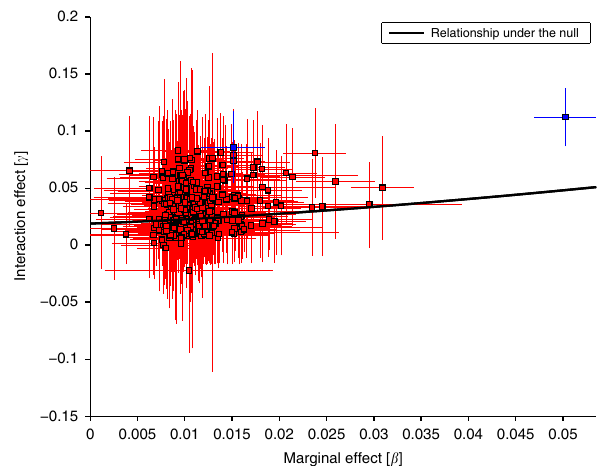
Fig. 6 Interaction vs marginal effects for 376 BMI-associated SNPs. Black line represents the relationship for a non-speci fi c variable, i.e., a variable with 0.05 marginal effect is expected to show an interaction effect of size ≈ 0.04. Only two of the SNPs show greater than expected interaction effect. Error bars represent 95% con fi dence